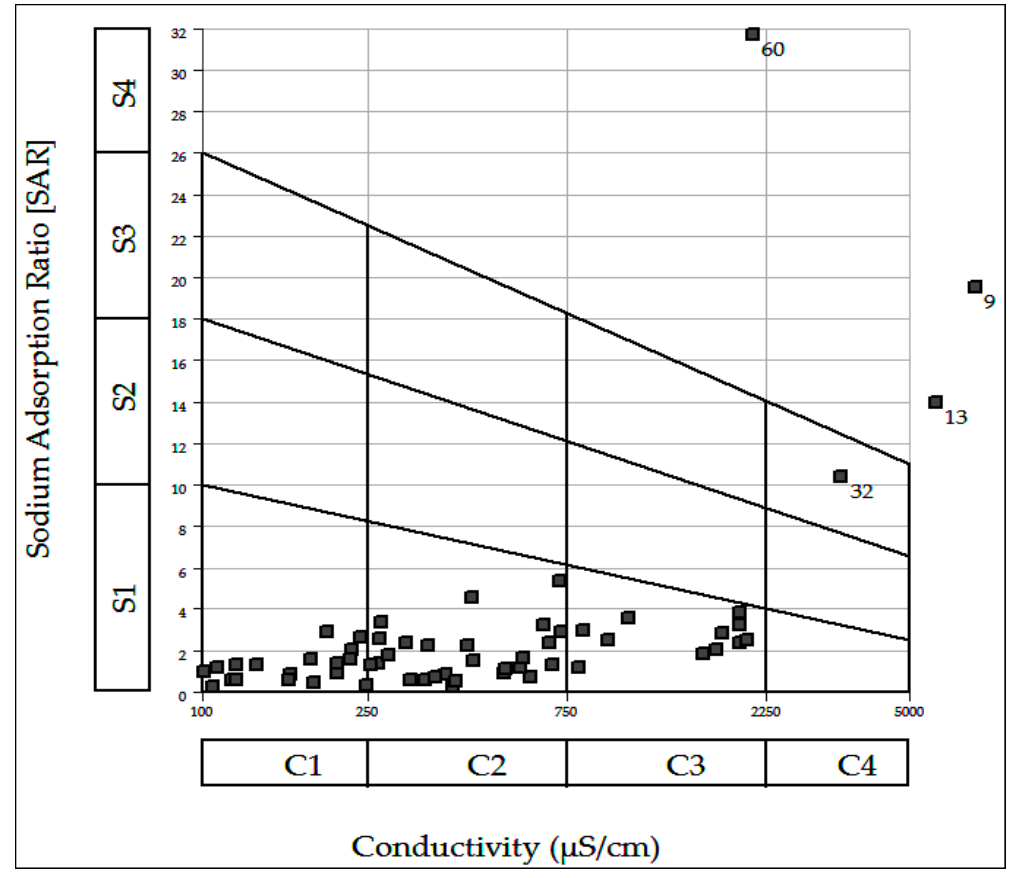
Figure 9. USSL classification of groundwater. C: Salinity Hazard; C1: Low, C2: Medium, C3: High,